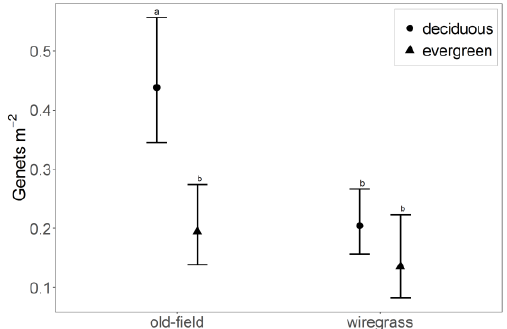
Figure 1. Hardwood genet density (least-squares means with 95% confidence intervals) in longleaf pine woodland according to groundcover type and leaf habit. Old-field groundcover is indicative of areas that have a history of soil disturbance (e.g., agriculture), whereas wiregrass is indicative of relatively undisturbed soils. Effects that do not share superscripted letters are significantly different at a 95% confidence level.